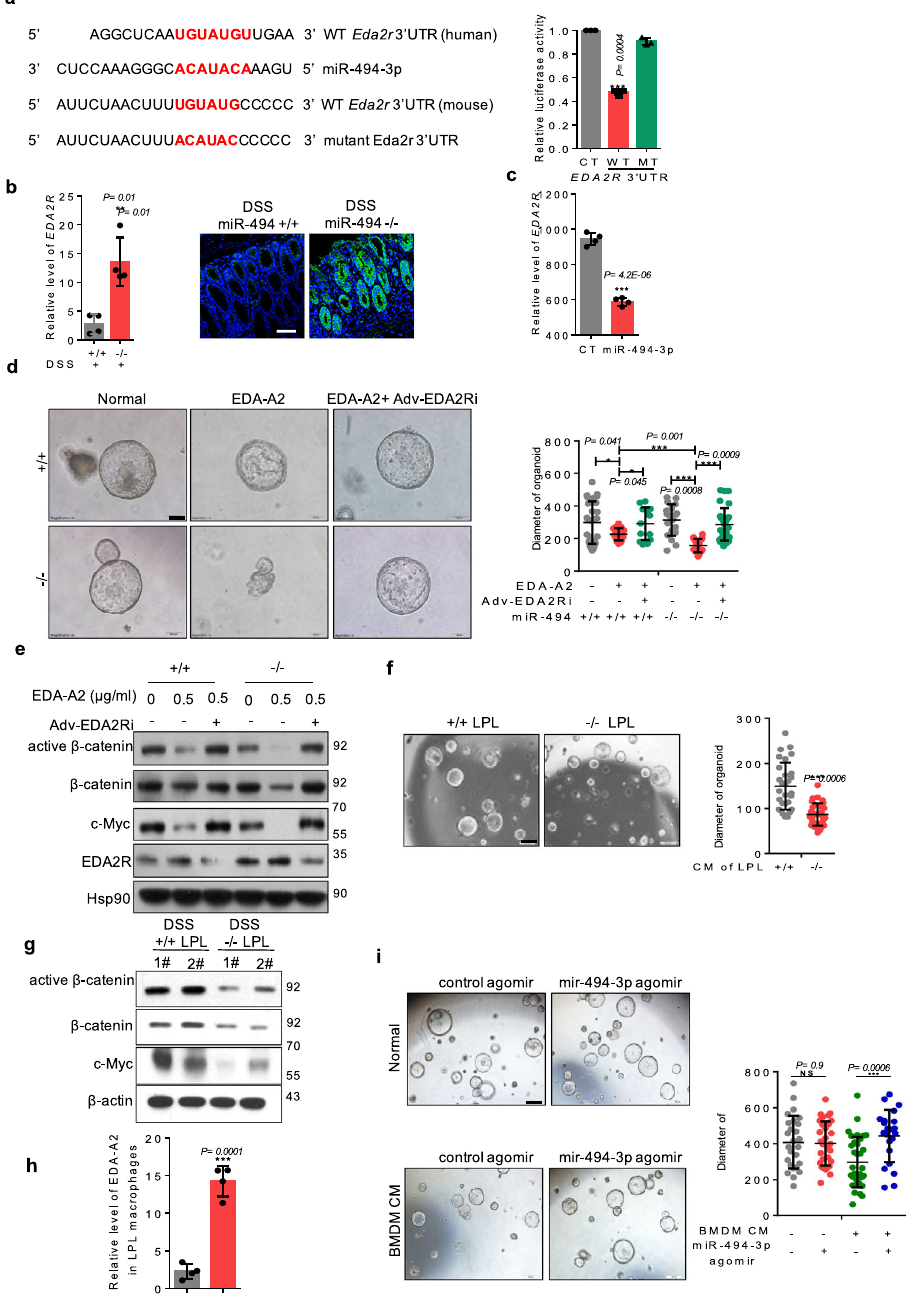
Fig. 3 EDA-A2/EDA2R, is identi fi ed as attenuating crypt stem cell proliferation in DSS-induced colitis. a Sequences of mouse and human EDA2R 3 ′ - untranslated regions (UTRs) and conservative miR-494-3p-binding sites. Luciferase activity of the reporter vector containing the WT or mutant 3 ′ -UTR of EDA2R was determined after co-transfection with control or miR-494-3p-mimic. b , c qRT-PCR and IF analysis were performed to measure the levels of EDA2R mRNA (normalized for β -actin) and protein level in colon tissues of DSS-treated WT ( + / + ) and DSS-treated miR-494 − / − mice ( b ) or in colonic crypts with miR-494-3p agomir and control agomir incubation ( c ). d Representative images and quanti fi cation of the size of mice colonic organoids. Organoids derived from the colonic crypts from miR-494 − / − mice and WT ( + / + ) mice were incubated with indicated treatment for 5 days, scale bar: 100 μ m. e Western blot analyses were used to determine the signaling of colonic organoids ( d ). f Representative images and quanti fi cation of the size of mouse colonic organoids which were cultured with the CM (supernatant of LPL: growth culture medium = 1:1 for 5 days), scale bar: 500 μ m. g Western blot was used to determine the signaling of colonic organoids ( d ). h Levels of EDA-A2 in LPL macrophages were determined by qRT-PCR (normalized by β -actin). LPL macrophages were isolated from mice provided with free access to drinking water with 3% DSS for 7 days. i Representative images and quanti fi cation of the size of mice colonic organoids which were incubated with miR-494-3p agomir and control agomir were cultured for 5 days with CM [medium of BMDM (with or without IL-1 β and IL-6 treatment): growth culture medium = 1:1]. Scale bar: 500 μ m. Data are presented as mean ± S.D. and analyzed by non-paired two-tailed Student ’ s t- test in panels ( a – d , f , h , i ). *** P ≤ 0.001; ** P ≤ 0.01; * P ≤ 0.05; NS, no signi fi